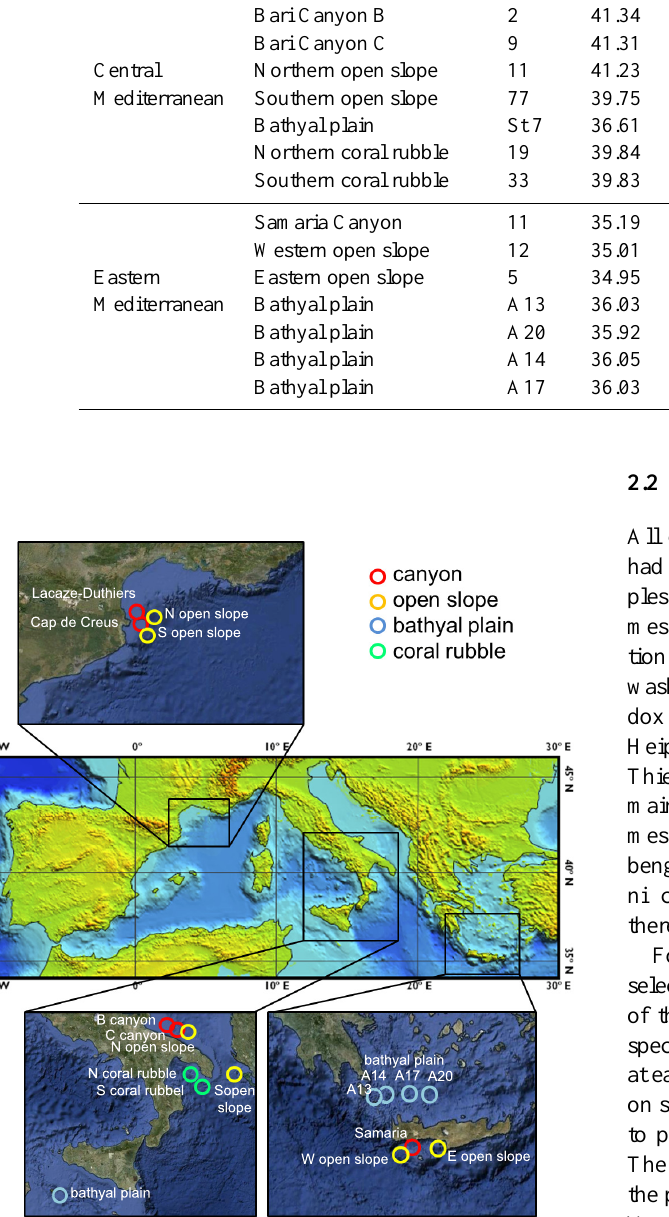
Fig. 1. Location and typology of the sampling sites in the deep Mediterranean